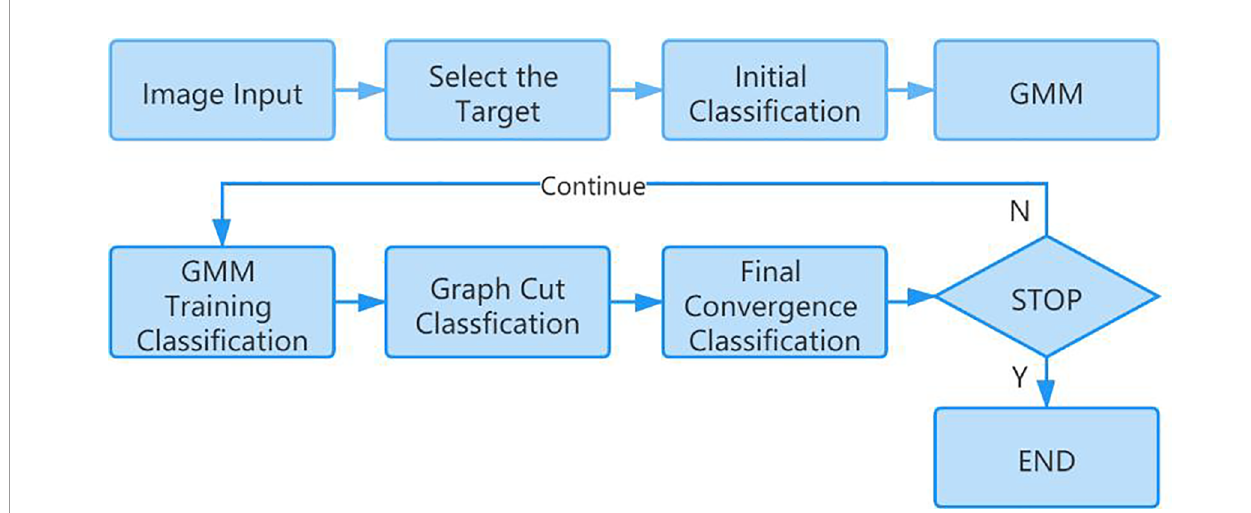
FIGURE 3 | The calculation process of the GrabCut algorithm.